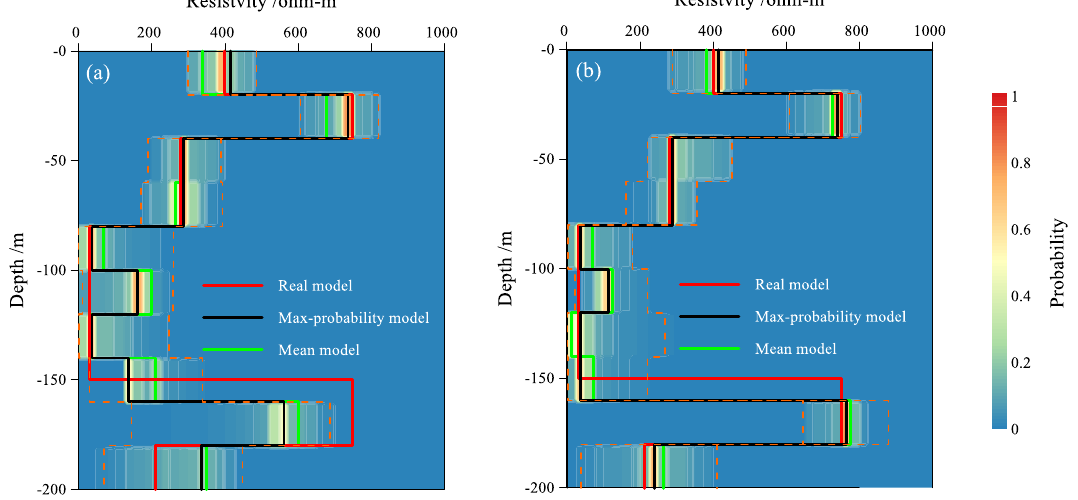
line), and the maximum probability model (black line). The orange dotted lines are the 5% and 95% confidence boundary of the pos- terior distribution in each layer. The MCMC sample using 𝜆 = 20 in Gaussian proposal distribution can improve deeper resistivity reso-